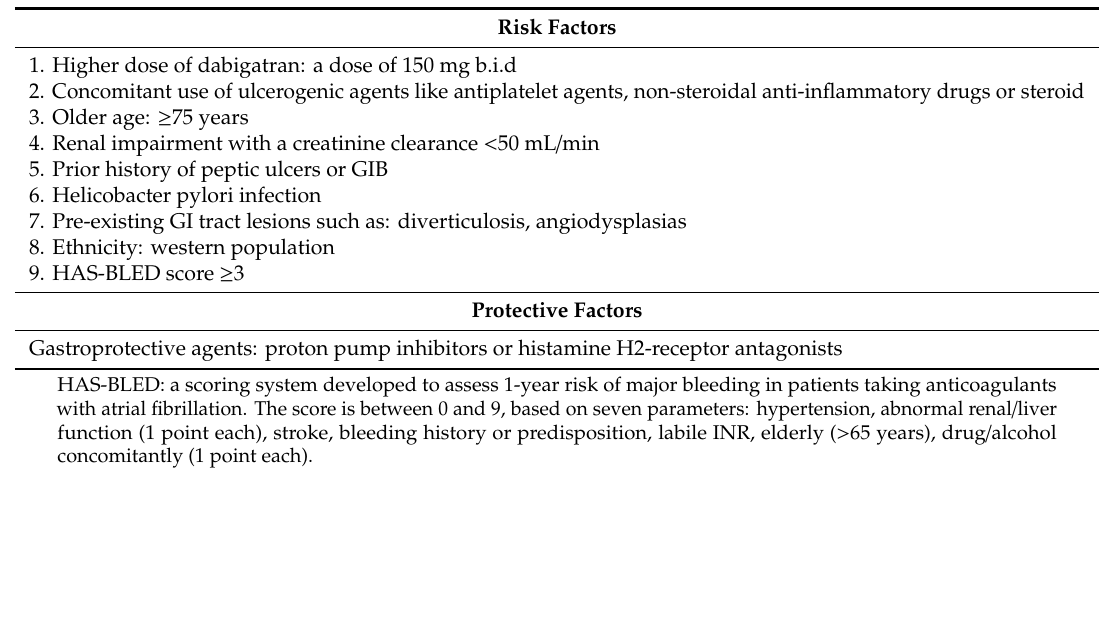
Table 2. Factors associated with NOACs-related gastrointestinal